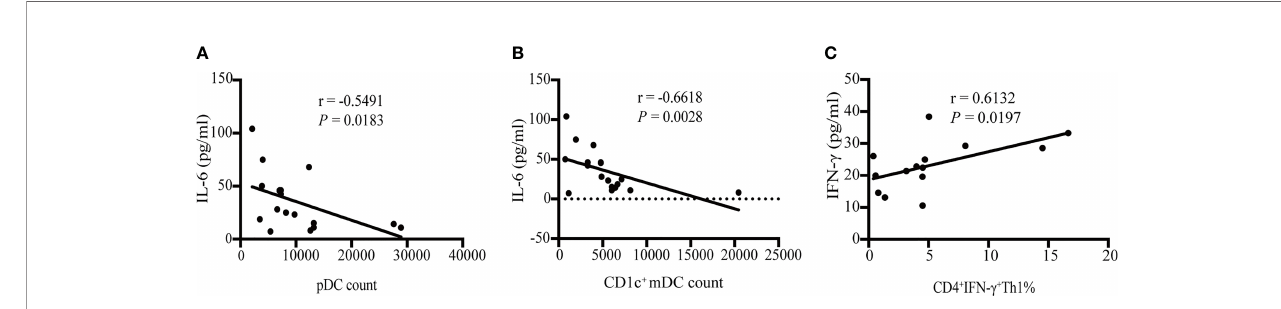
FIGURE 5 | Spearman correlation between cytokines and immunocytes. (A) Correlation analysis of IL-6 level and pDC count in KD patients pre-IVIG treatment (n = 18). (B) Correlation analysis of IL-6 level and CD1c + mDC count in KD patients pre-IVIG treatment (n = 18). (C) Correlation analysis of IFN- g level and the percentage of circulating CD4 + IFN- g + Th1 in KD patients pre-IVIG treatment (n = 14).